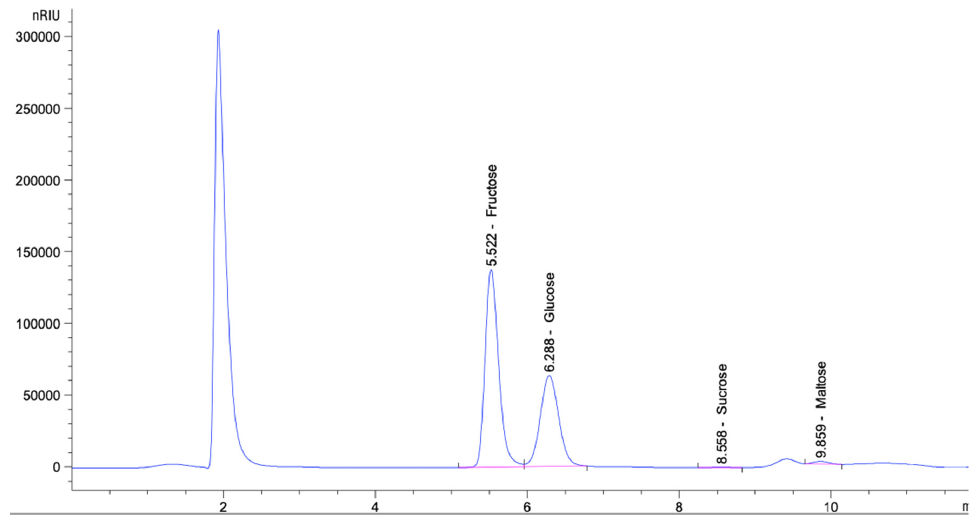
Figure 1. Sugar contents in honey.